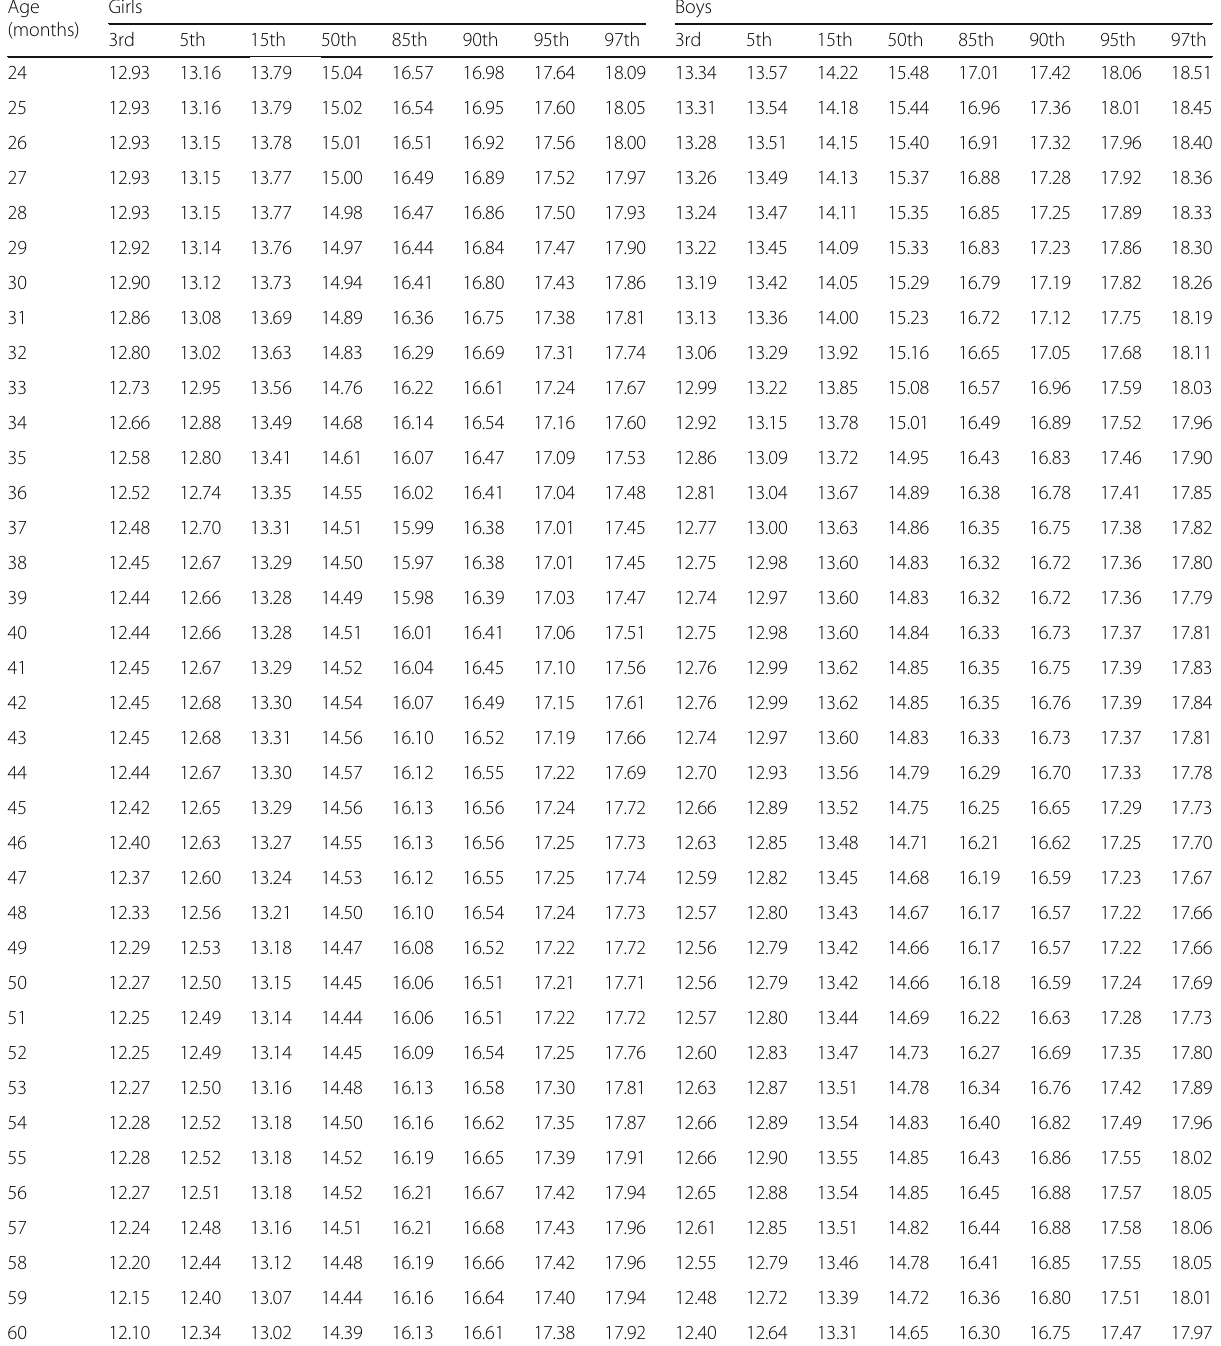
Table 4 Percentiles of BMI (kg/m 2 )-for-age for girls and boys, age in months Age (months)